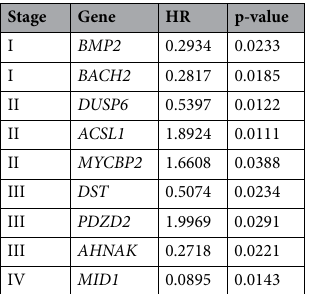
Table 3. Statistically significant genes from stage-specific survival analyses. HR hazard ratio.